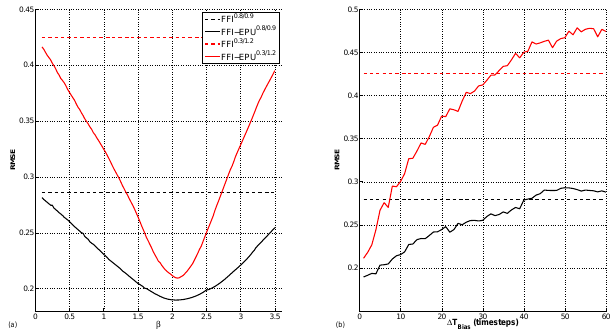
Fig. 9. (a) RMSE of FFI-EPU (solid line) over the first year of prediction as a function of the width of the sampling distribu- tion (Eq. 20) scaled with the parameter β (see text) for the cases c m = 0 . 8, c m z = 0 . 9 /c m = 0 . 3, c m z = 1 . 2. (b) RMSE of FFI-EPU over the first year of prediction as a function of the bias correction interval 1T Bias , for the case c m = 0 . 8, c m z = 0 . 9 (black line) and c m = 0 . 3, c m z = 1 . 2 (red line). FFI (dashed lines) is superimposed for reference in both